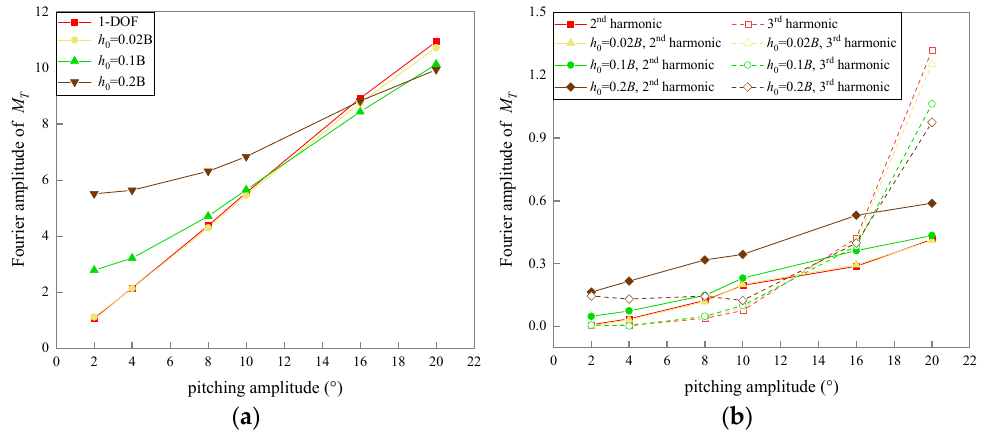
Figure 17. Variation in Fourier amplitude of aerodynamic moment with pitching amplitude. ( a ) The fundamental frequency; ( b ) Second harmonic and third harmonic.